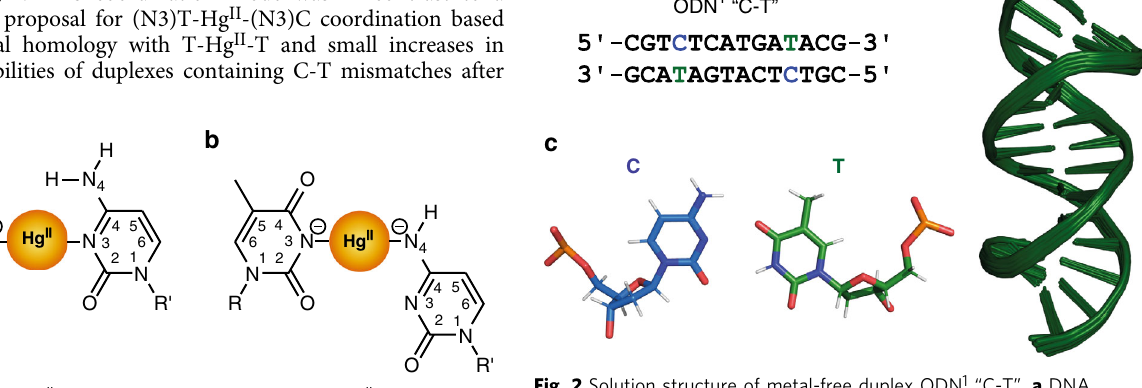
Fig. 2 Solution structure of metal-free duplex ODN 1 “ C-T ” . a DNA sequence. Blue and green bases indicate C-T mismatches. b Overlay of 20 lowest energy structures. The structures were aligned to a representative model (#1) containing fewest outliers in the geometric quality criteria. c Facial recognition of non-planar, C-T pair in model #1 (PDB